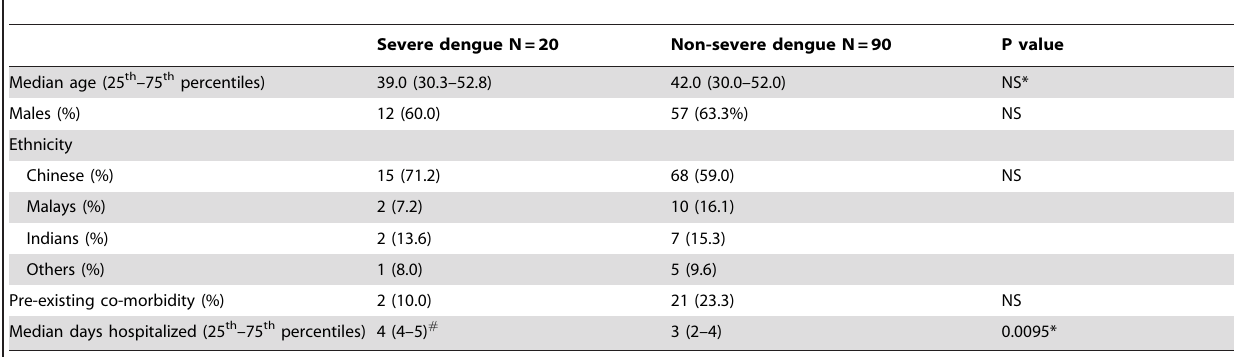
Table 6. Demographics of the hospitalized dengue cases with severe or non-severe dengue.